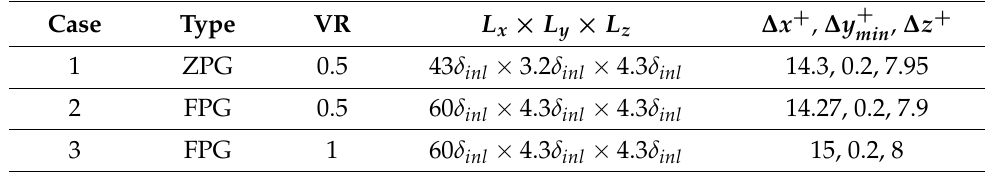
Table 1. Numerical